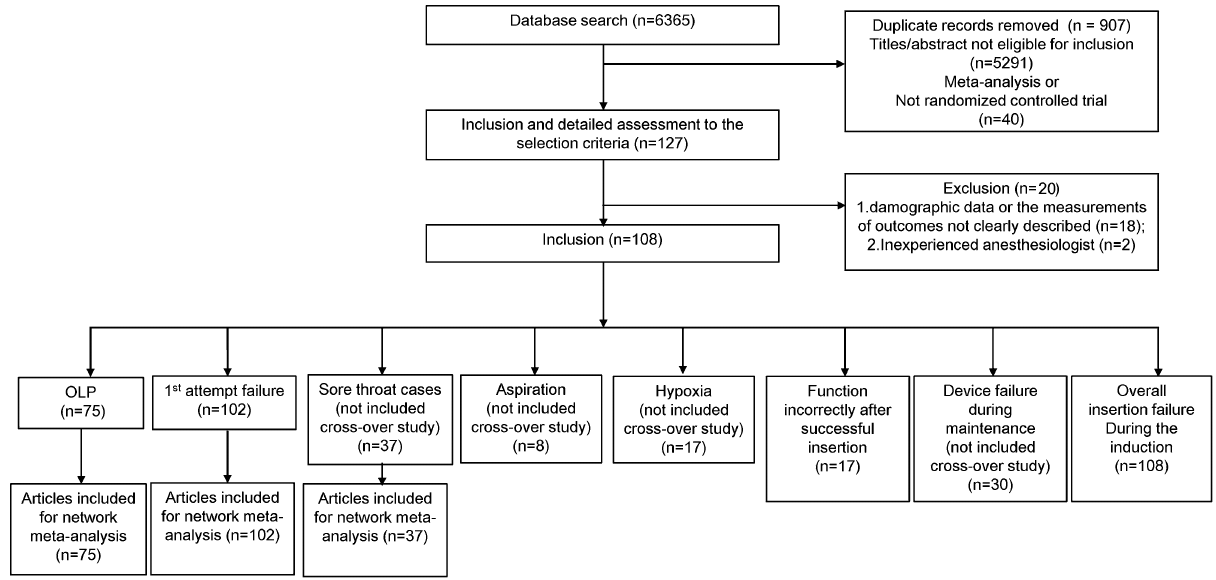
Figure 1. Summary of trial identification and selection. OLP, oropharyngeal leak pressure.